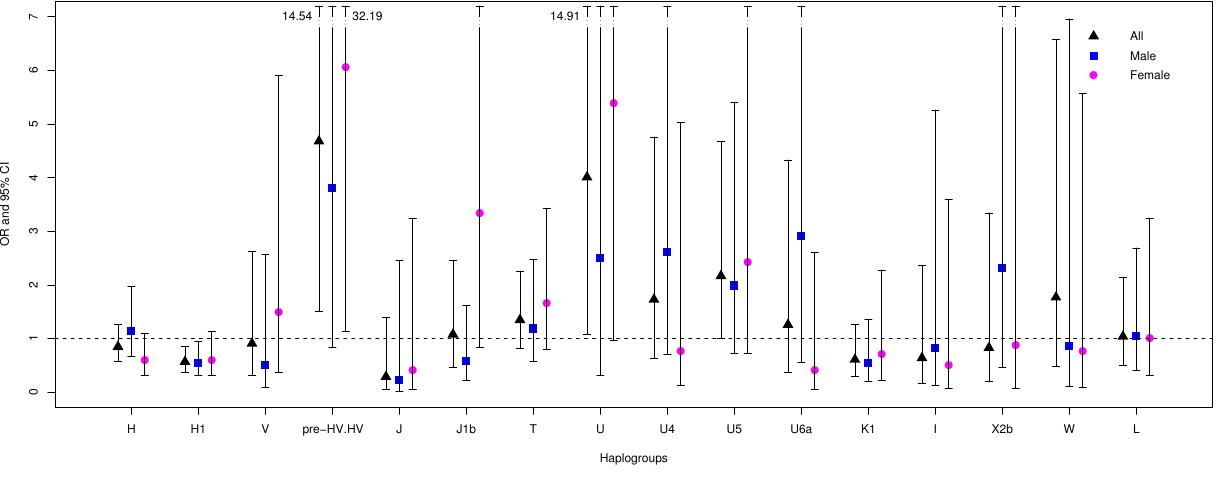
Figure 2 Logistic regression odds ratios and confidence intervals (CIs) for mtDNA haplogroup association with ischemic stroke risk . Bars indicate 95% CIs and are shown as dotted lines when the upper confidence limit (CL) is over 7. The upper CL is indicated when it is over 7 and the respective lower CL is greater than 1.